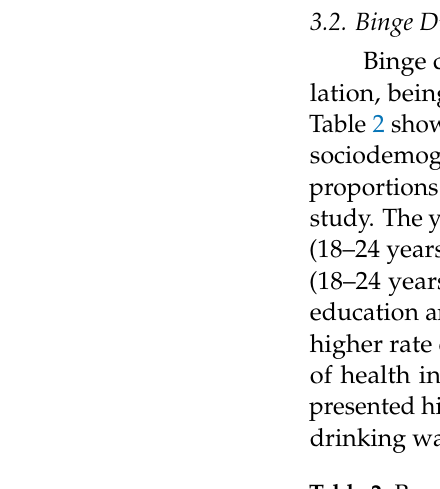
Table 2. Proportion of binge drinking among men and women according to sociodemographic and health-related